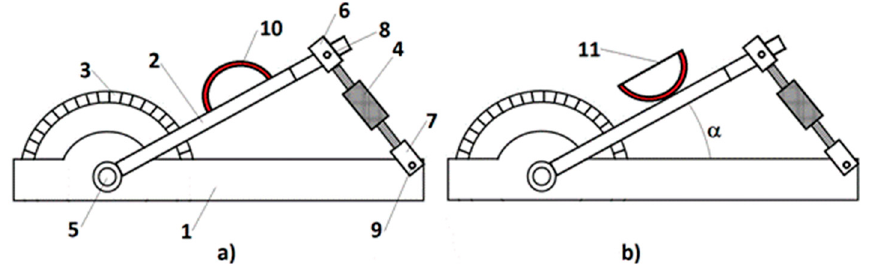
Figure 9. Tester for friction coefficient determination between steel plane and ball joint bearing sample, (a) for the contact between a spherical surface of sample 10 with tilting plane 2; (b) for the contact between a frontal plane of sample 10 with tilting plane 2.